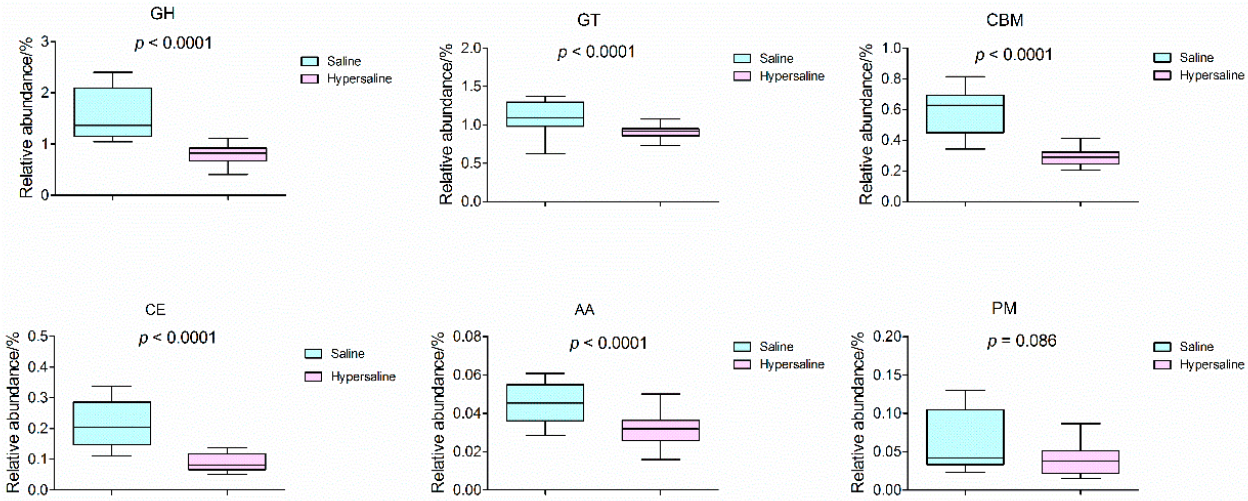
Figure 7. Heatmap of different KEGG pathways at level 2 between the saline and hypersaline soils (FDR < 0.05).